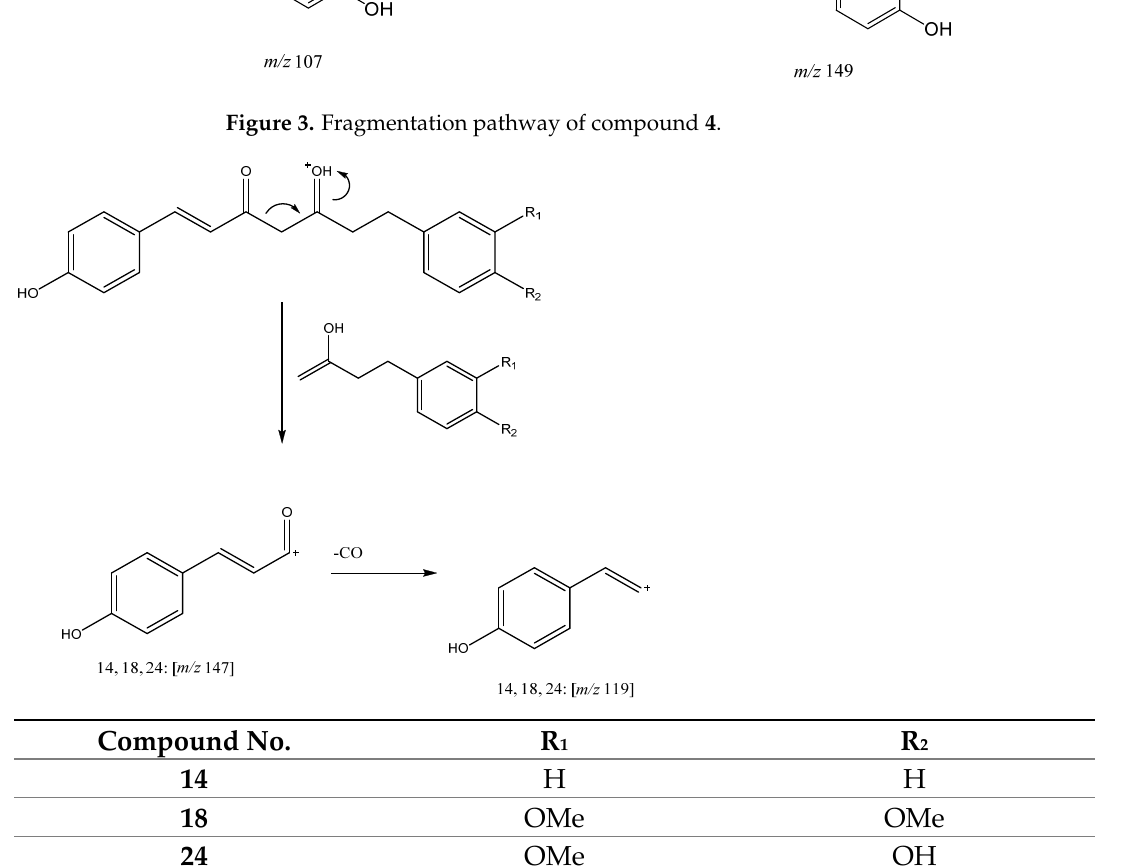
Figure 4. Fragmentation pathway of compounds 14 , 18 and 24 .